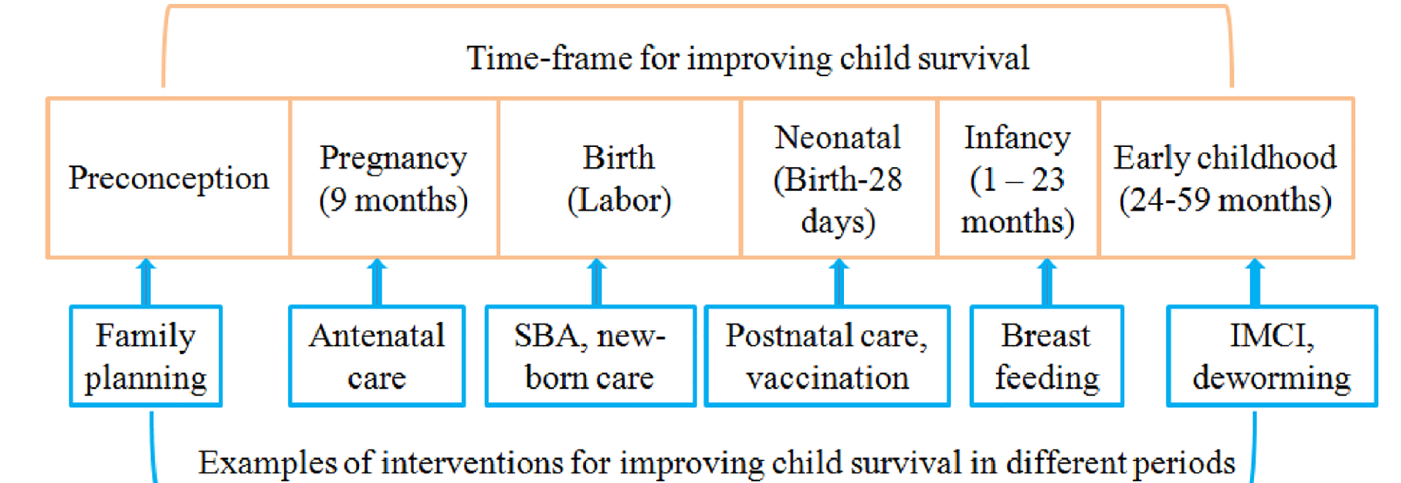
Fig 2. Conceptual framework on defining